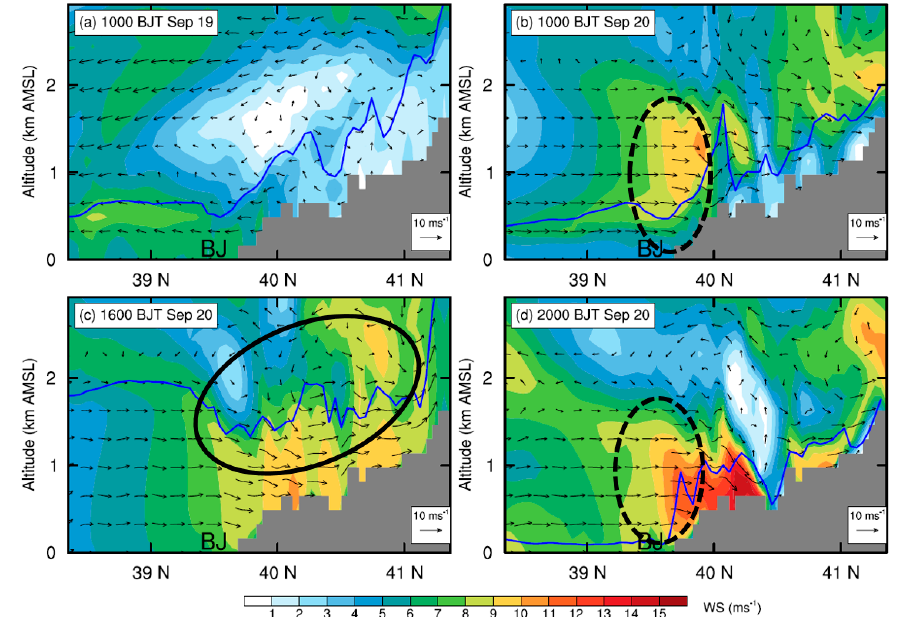
Figure 7. Vertical cross sections of simulated horizontal wind speed (WS) at ( a ) 10:00 h BJT on 19 September, and ( b – d ) 10:00, 16:00, and 20:00 h BJT on 20 September, overlaid with the wind vector fields. The locations of the PBL top are marked by the blue lines for each panel. The black solid circle in ( c ) illustrates the approximate locations of mountain-plain breeze circulation, and the black dashed circles in ( b ) and ( d ) denote the locations of the LLJ. Note that the vertical velocity is multiplied by a factor of 10 when plotting the wind vectors, and the approximate location of Beijing is indicated using “BJ”. The locations of the cross section are marked by the violet line in Figure 6b.